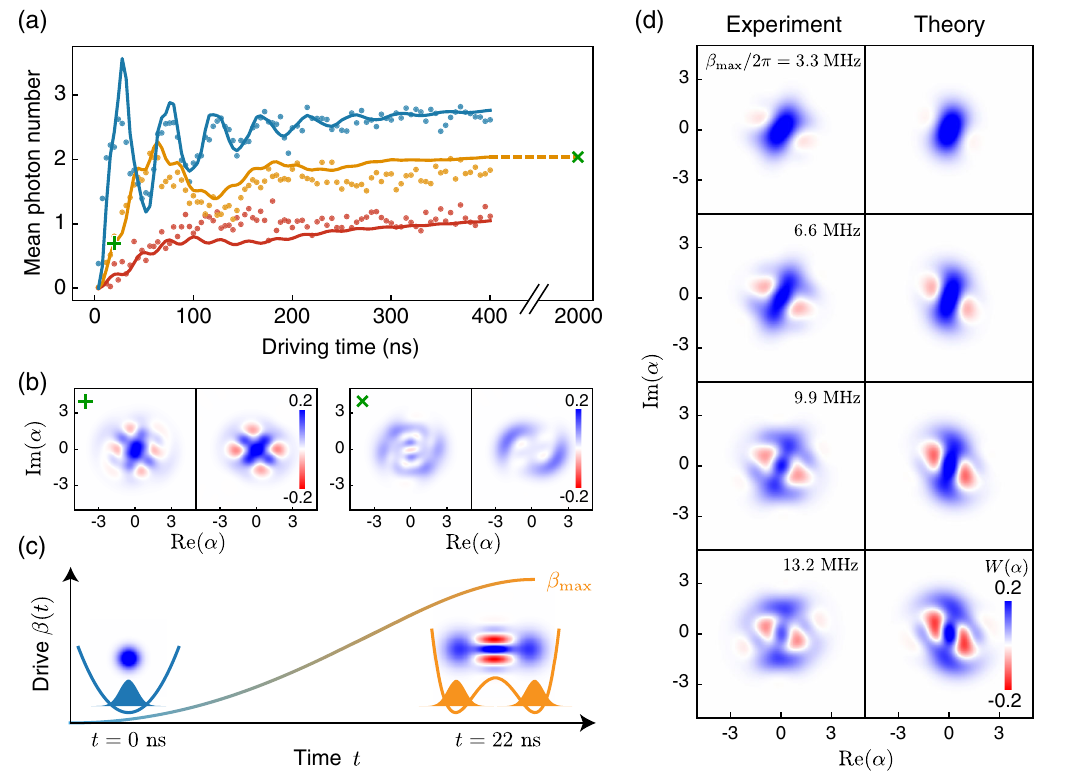
FIG. 4. Transient-state dynamics of the parametrically driven KPO. (a) Time evolution of the mean photon number up to 400 ns at Δ = 2 π ¼ 24 . 6 MHz for β = 2 π ¼ 3 . 5 MHz (red line), β = 2 π ¼ 5 . 8 MHz (yellow line), and β = 2 π ¼ 11 . 5 MHz (blue line). (b) Both state reconstructions at t ¼ 20 ns (transient state) and t ¼ 2000 ns (steady state), showing good agreement with theory (left is experiment; right is theory) with fidelities of 0.93 and 0.94, respectively. (c) Pulse amplitude profile β ð t Þ for cat-state generation. A pulse length of 22 ns is chosen from simulation. Ramping β up from 0 to β drives the resonator from the vacuum state into an oscillating cat state. max (d) Wigner functions W ð α Þ of generated cat states, reconstructed from tomography, for different β at Δ = 2 π ¼ − 6 . 7 MHz. These max measurement results match closely (fidelities 0.98, 0.95, 0.92, 0.89) with